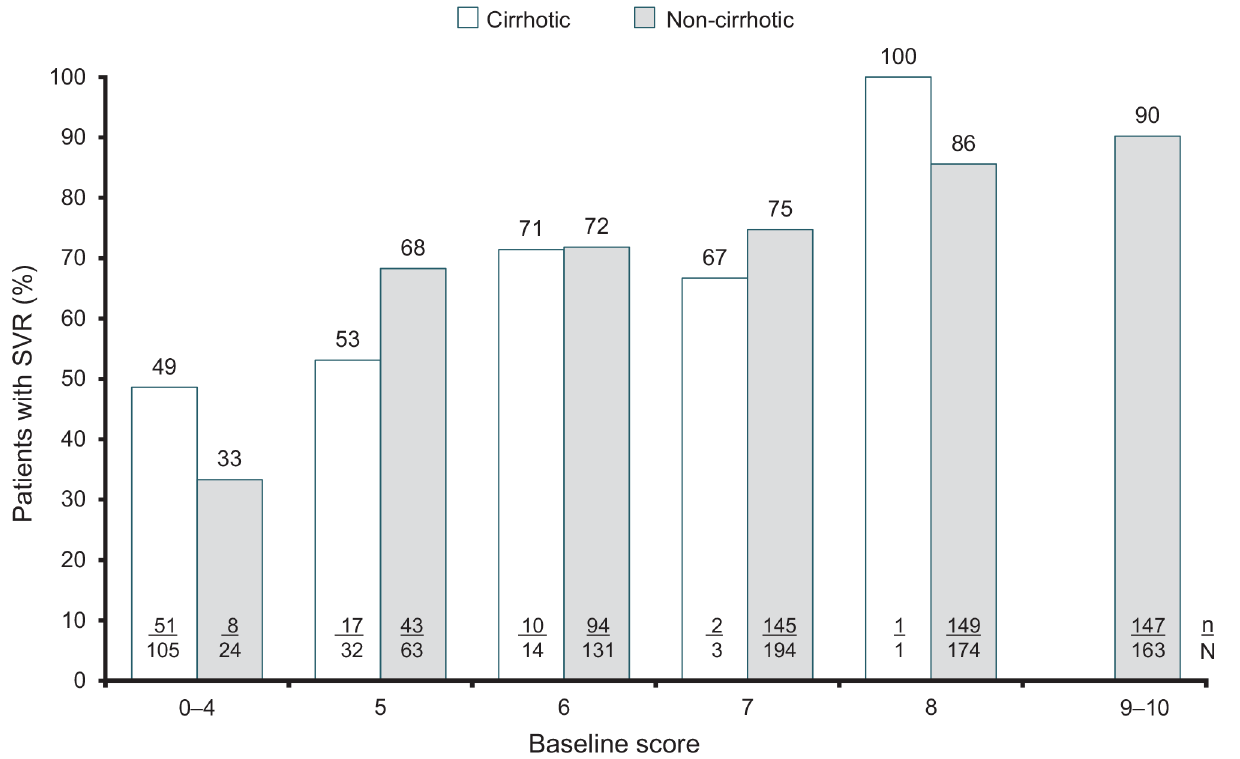
Fig 12. Rate of response in treatment-naive cirrhotic and noncirrhotic Caucasian and patients with HCV genotype 3 by baseline score. Patients with missing scores omitted (noncirrhotic; n = 48, cirrhotic; n = 11). a Patients with missing information on cirrhosis status were given the same score as no